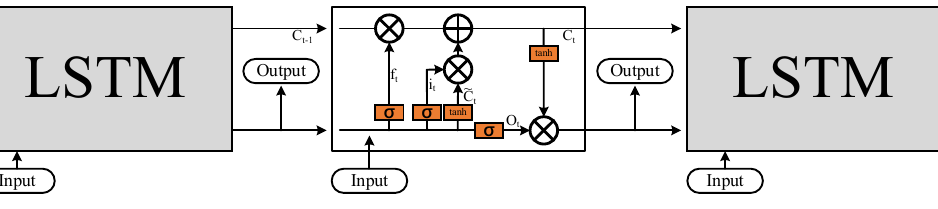
Figure 10. The working flow of the long short-term memory network.